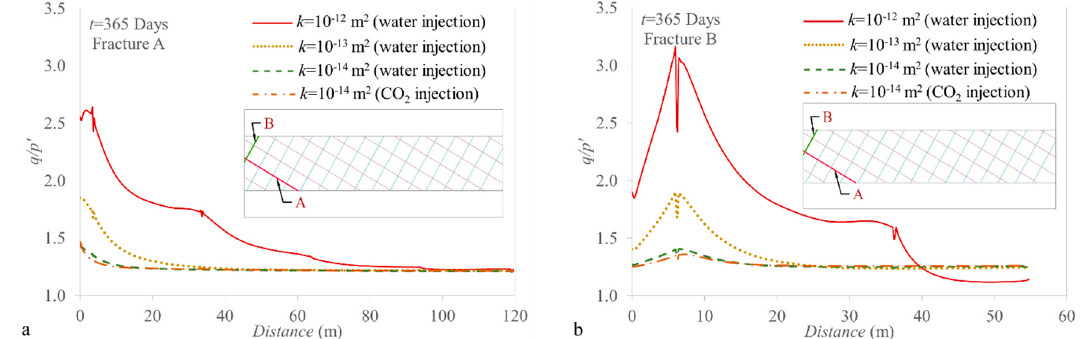
Figure 13. 𝑞/𝑝′ trajectory along the fractures near to the injection point when cold water or CO 2 are injected during 1 year, for ( a ) fracture A and ( b ) fracture B. Note that the fluctuations indicate the intersections between fractures.